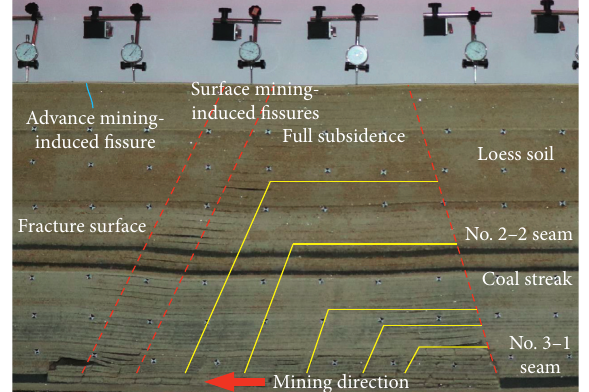
Figure 4: The dynamic development of mining-induced fissures in working face